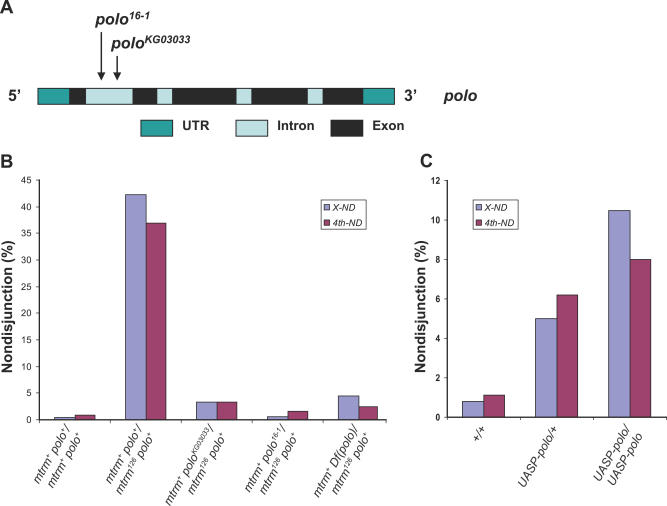
Reducing the Dose of polo+ Suppresses mtrm Defects, and Increasing the Dose of polo+ Partially Mimics the Effects of mtrm
(A) Schematic diagram of the polo gene (black boxes depict the five exons) indicating the insertions sites for the two polo alleles (polo16–1 and poloKG03033).(B) Summary of the genetic interaction of mtrm and polo mutants as examined by assaying the frequency of nondisjunction of X and 4
th chromosomes. As shown by Harris et al. [9], mtrm/+ heterozygotes display high levels of nondisjunction for both achiasmate X and 4
th chromosomes (42% and 37%, respectively) when compared to mtrm+/mtrm+ females. However, simultaneously reducing the dose of polo, as a result of heterozygosity for either the two P element insertion site mutants or a deficiency that uncovers polo (Df(3L)rdgC-co2) suppresses the meiotic phenotype of mtrm/+ heterozygotes.(C) Expression of the UASP-polo+ transgene in mtrm+/mtrm+ females results in a dose-dependent increase in the frequency of achiasmate nondisjunction for both the X and the 4
th chromosomes. However, two weaker alleles of polo, polo01673 and polo1, showed little or no suppression of the segregational defect (unpublished data). The polo1 mutant, which is the weakest of the known polo mutants (it is viable over a deletion) is the result of a point mutation at base pair 725, V242E, in the kinase domain. Although polo01673 is recessive lethal, it must retain some degree of function because it complements at least one other hypomorphic allele of polo, polox8. The results indicate that reduction of polo+ dosage rescues mtrm defects and the suppressive effect of a given polo mutant correlates with the severity in the reduction of Polo function.